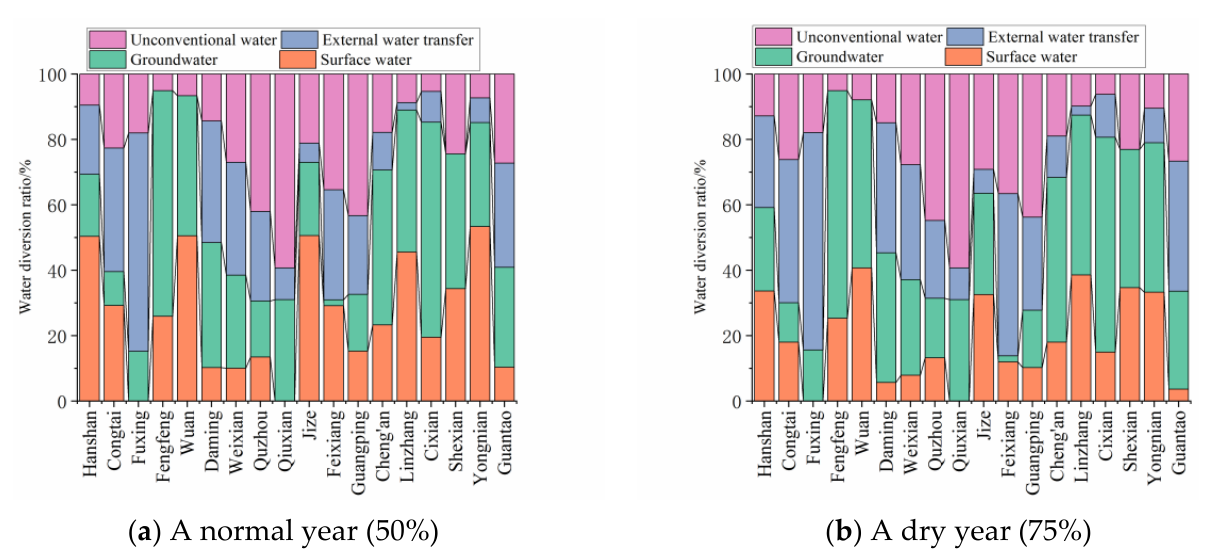
Figure 14. Agricultural water shortage in 2035.